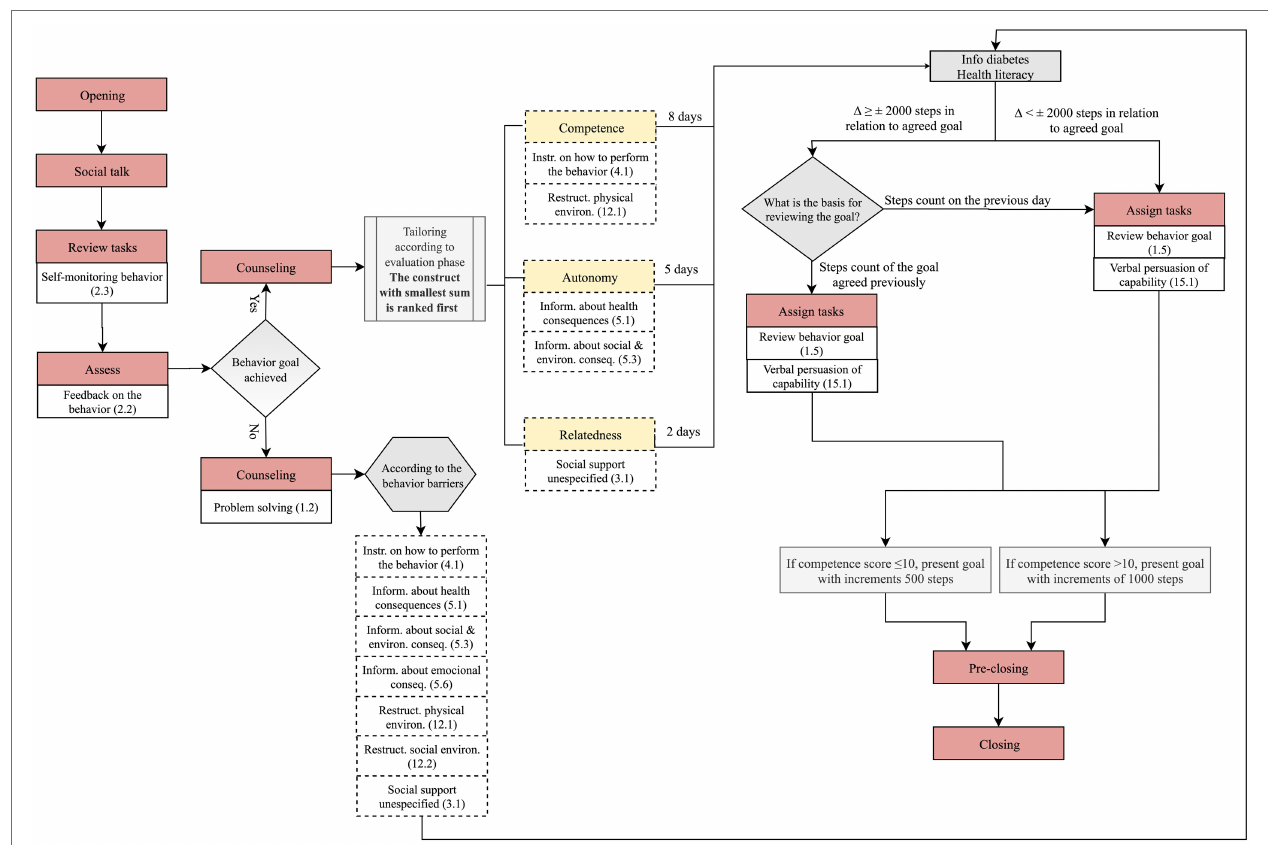
FIGURE 5 | Dialogue flow in day 3 and odd days of physical activity component of the follow-up